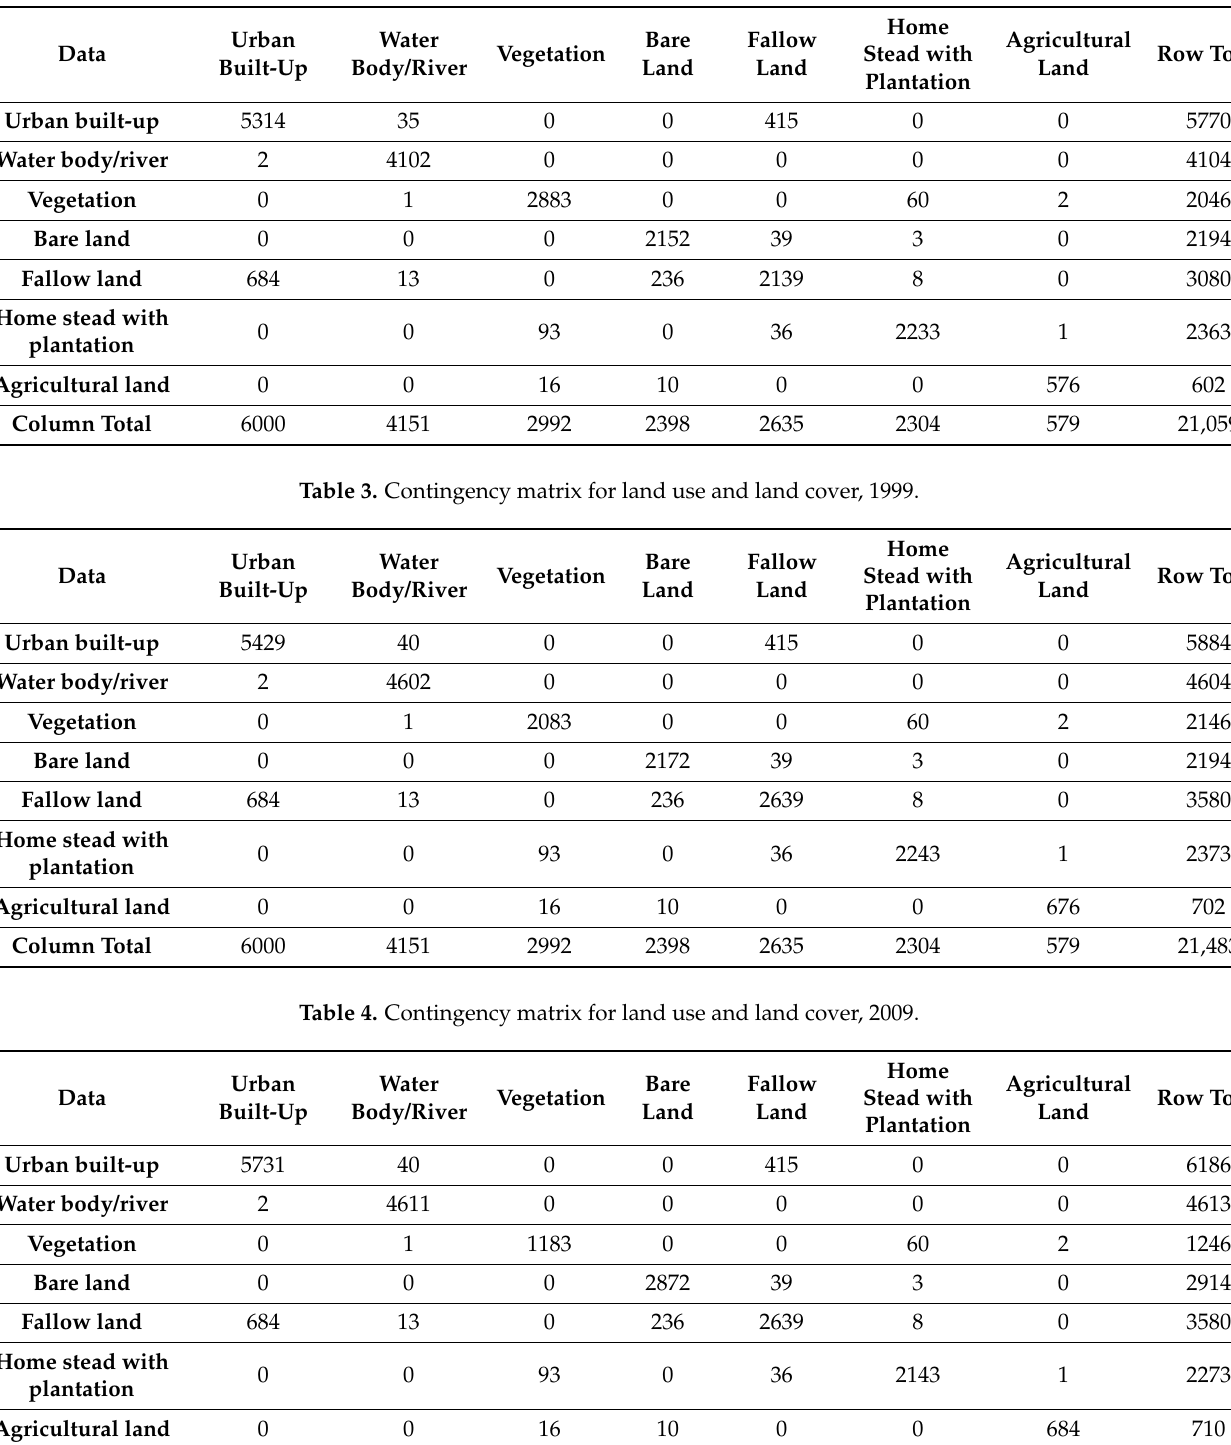
Table 2. Contingency matrix for land use and land cover, 1989.